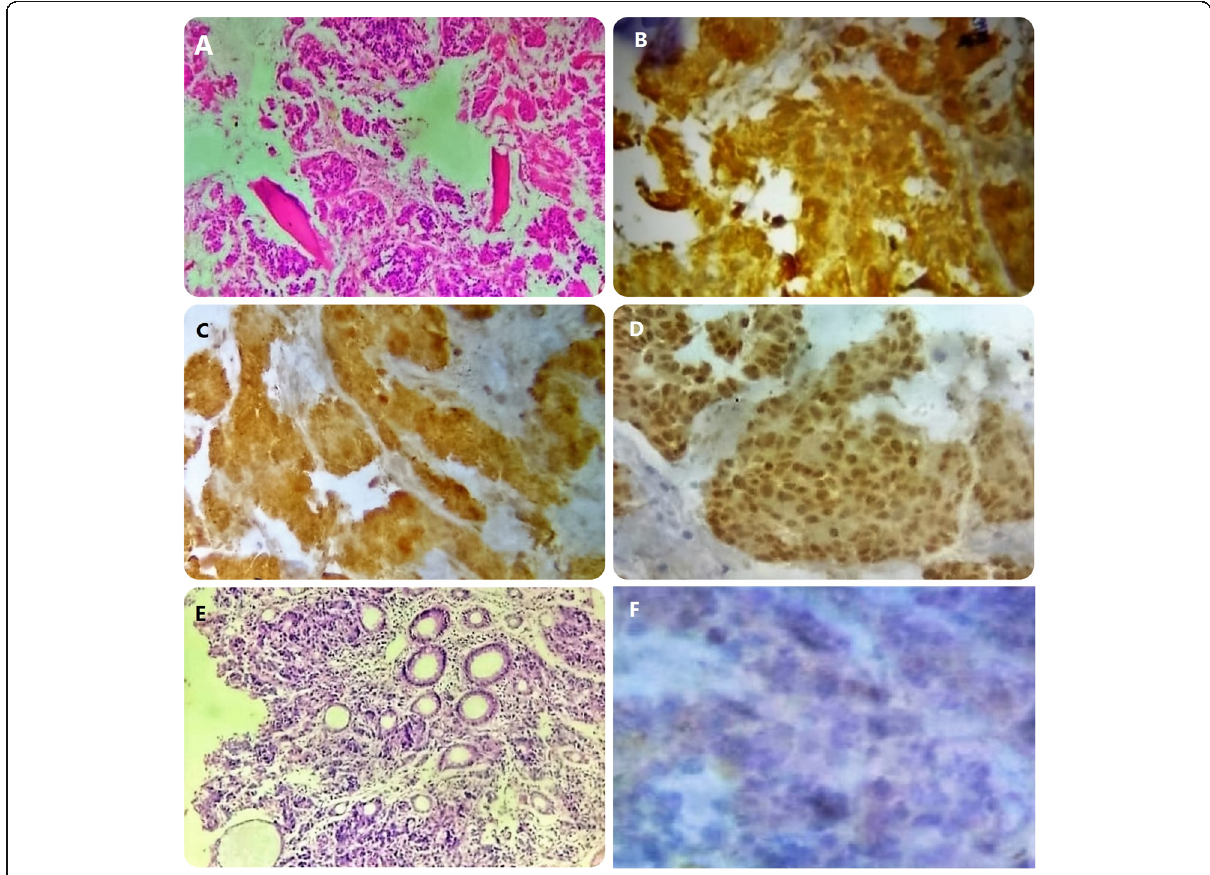
Fig. 1 a : H&E; BM trabeculae with intervening nests of malignant epithelial cells admixed with foci of necrosis (× 100). b Positive cytoplasmic staining of neoplastic cells for CK (× 400). c Positive cytoplasmic staining of neoplastic cells for CK20 (× 400). d Positive nuclear staining of neoplastic cells for CDX-2 (× 400). e Colonoscopic biopsy showing the same malignant proliferation demonstrated in BM, with acinar and sheeting patterns separated by desmoplasia (× 100). f Negative staining of neoplastic cells for WT-1 (×